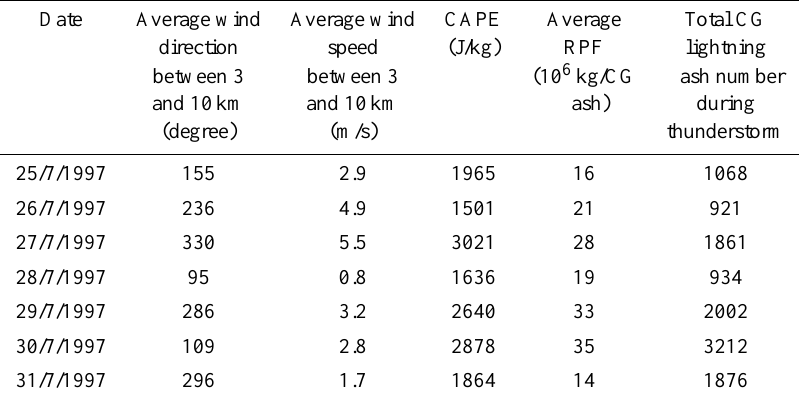
Table 1. Sounding and CG lightning flash data Date Average wind Average wind CAPE Average Total CG direction speed (J/kg) RPF lightning between 3 between 3 (10 6 kg/CG flash number and 10km and 10km flash) during (degree) (m/s) thunderstorm 25/7/1997 155 1965 26/7/1997